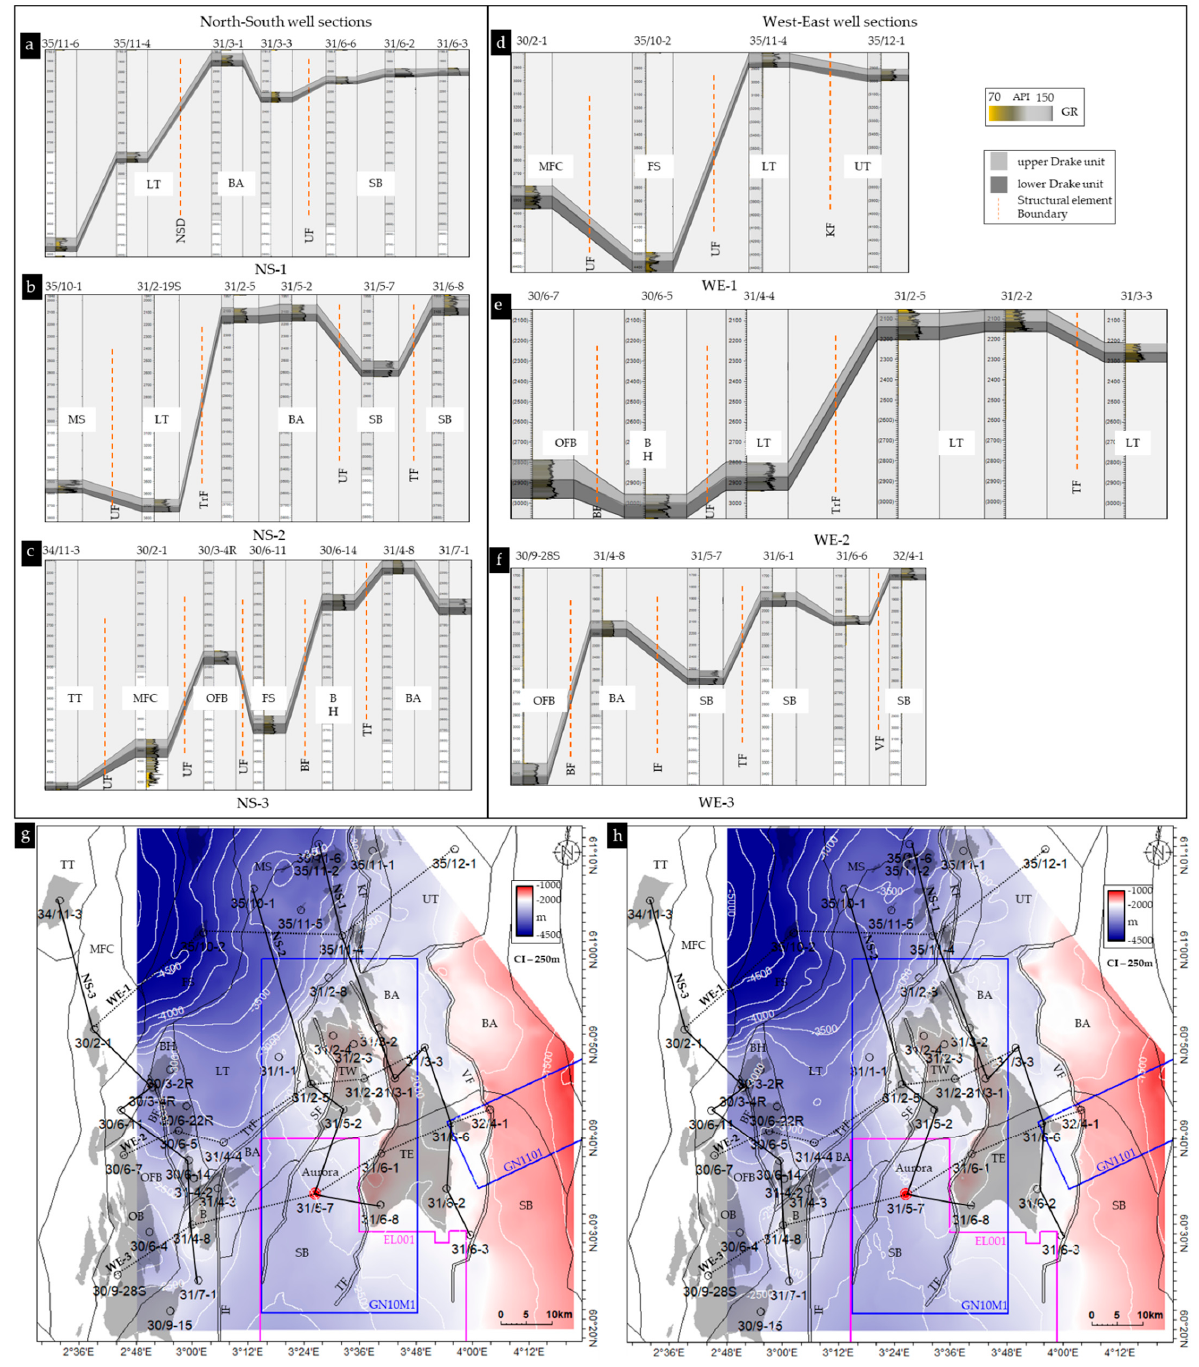
Figure 7. Well correlations flattened on 0 m TVDSS show the present day structural position of upper and lower unis of the Drake Formation: north–south sections ( a – c ), and east–west sections ( d – f ). The structural elements with corresponding boundaries in between wells are also marked. The depth structure maps of upper ( g ) and lower ( h ) Drake units also illustrate the well correlations with structural elements and major faults (i.e., structural elements: BA = Bjørgvin Arch; BH = Brage Horst; FS = Flatfisk Slope; HP = Horda Platform; NSD = Nordfjord–Sogn Detachment; LT = Lomre Terrace; MS = Marflo Spur; SB = Stord Basin; TT = Tjalve Terrace; UT = Uer Terrace. Faults: BF =